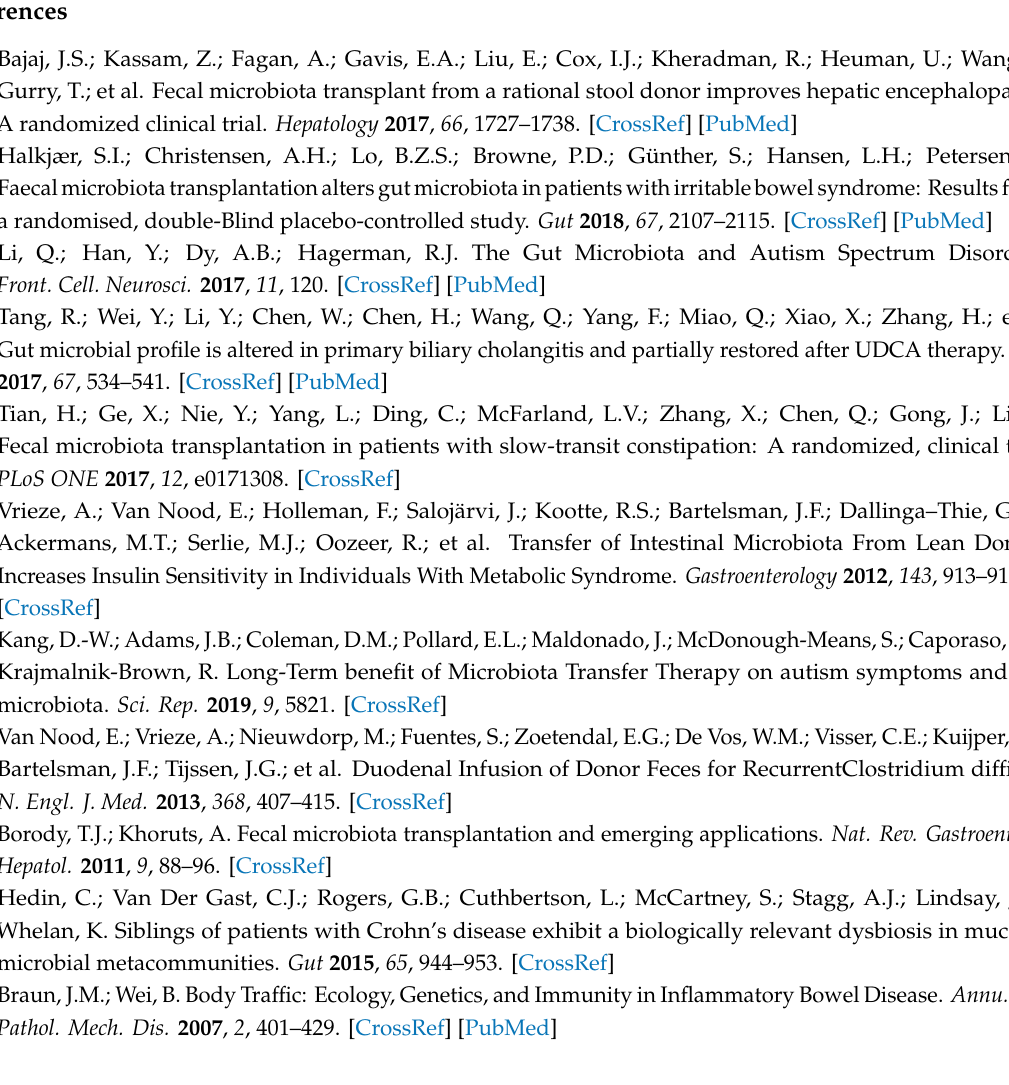
Figure S1: Comparison of the sum of Mayo endoscopic score between responders and non-responders in the mono-AFM and A-FMT groups during the short-term evaluation, Figure S2: Short-term e ffi cacy of A-FMT compared by ongoing and past medication with anti-tumor necrosis factor α and corticosteroid, Table S1: Microbial analysis data of five patients who were maintained without recurrence for 24